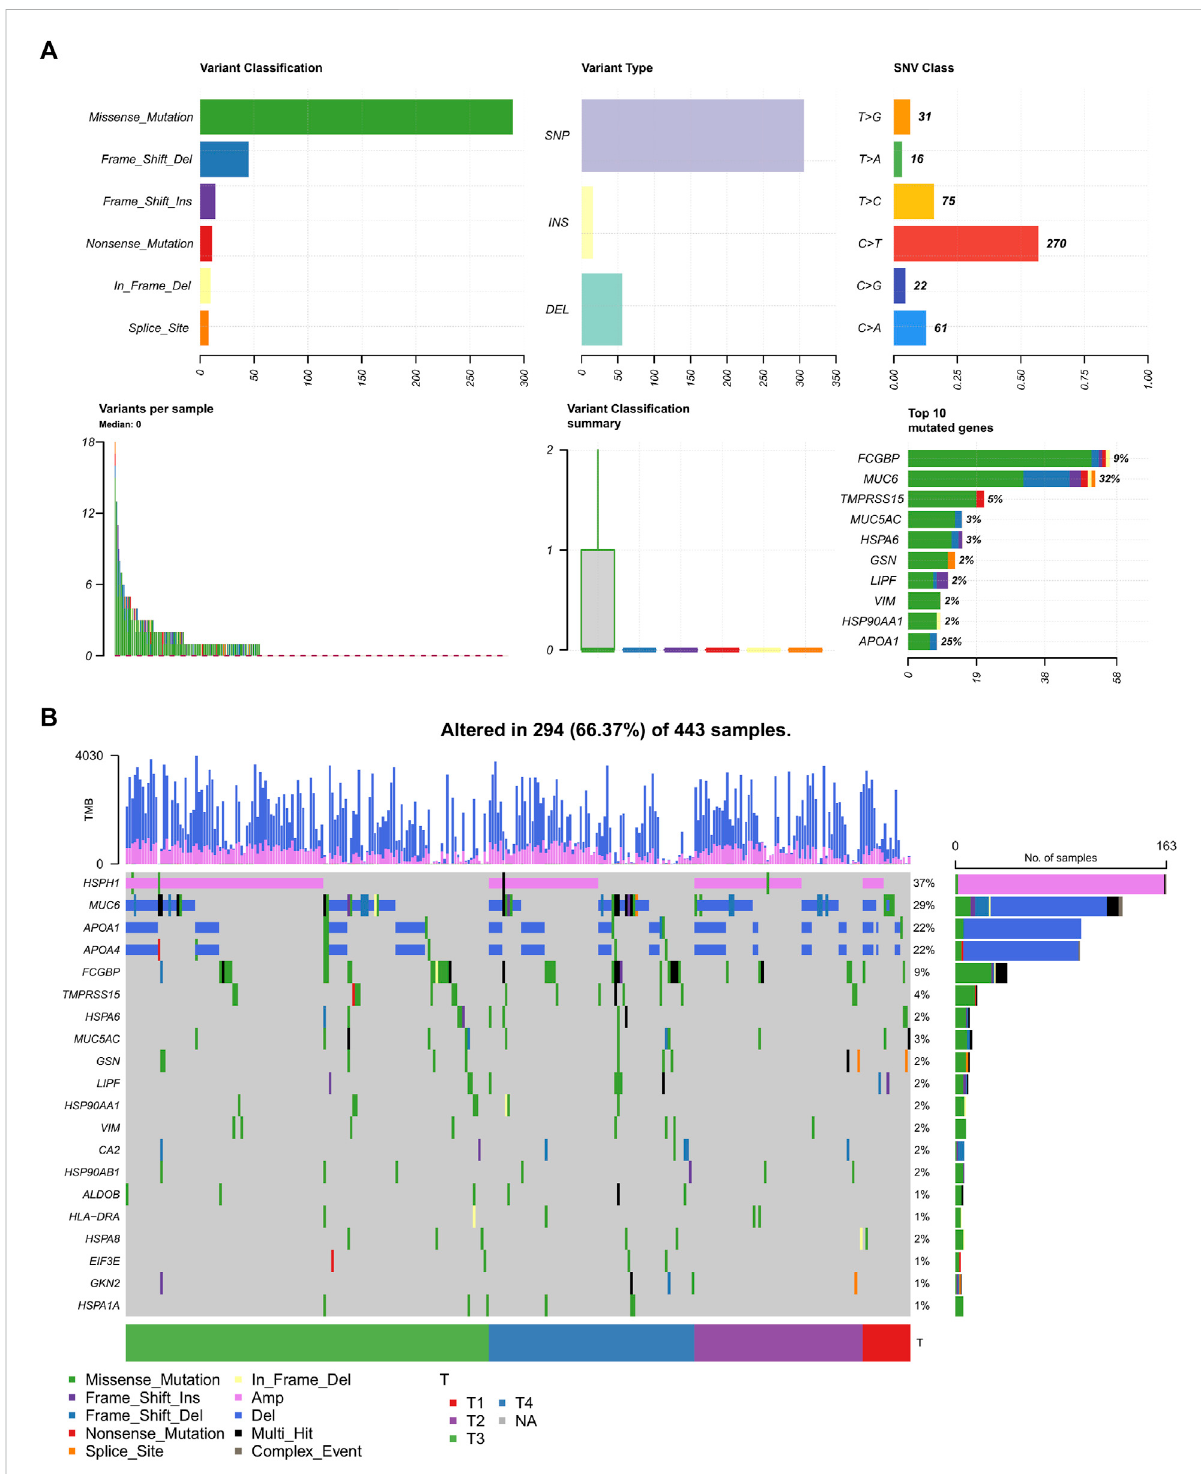
FIGURE 4 Mutational landscape in 64 DEGs. (A) Overview of the mutational frequency. (B) Mutation waterfall plot in the different T stages. SNP, single- nucleotide polymorphism; DEL, deletion; INS, insertion; SNV, single-nucleotide variant; Amp, ampli fi